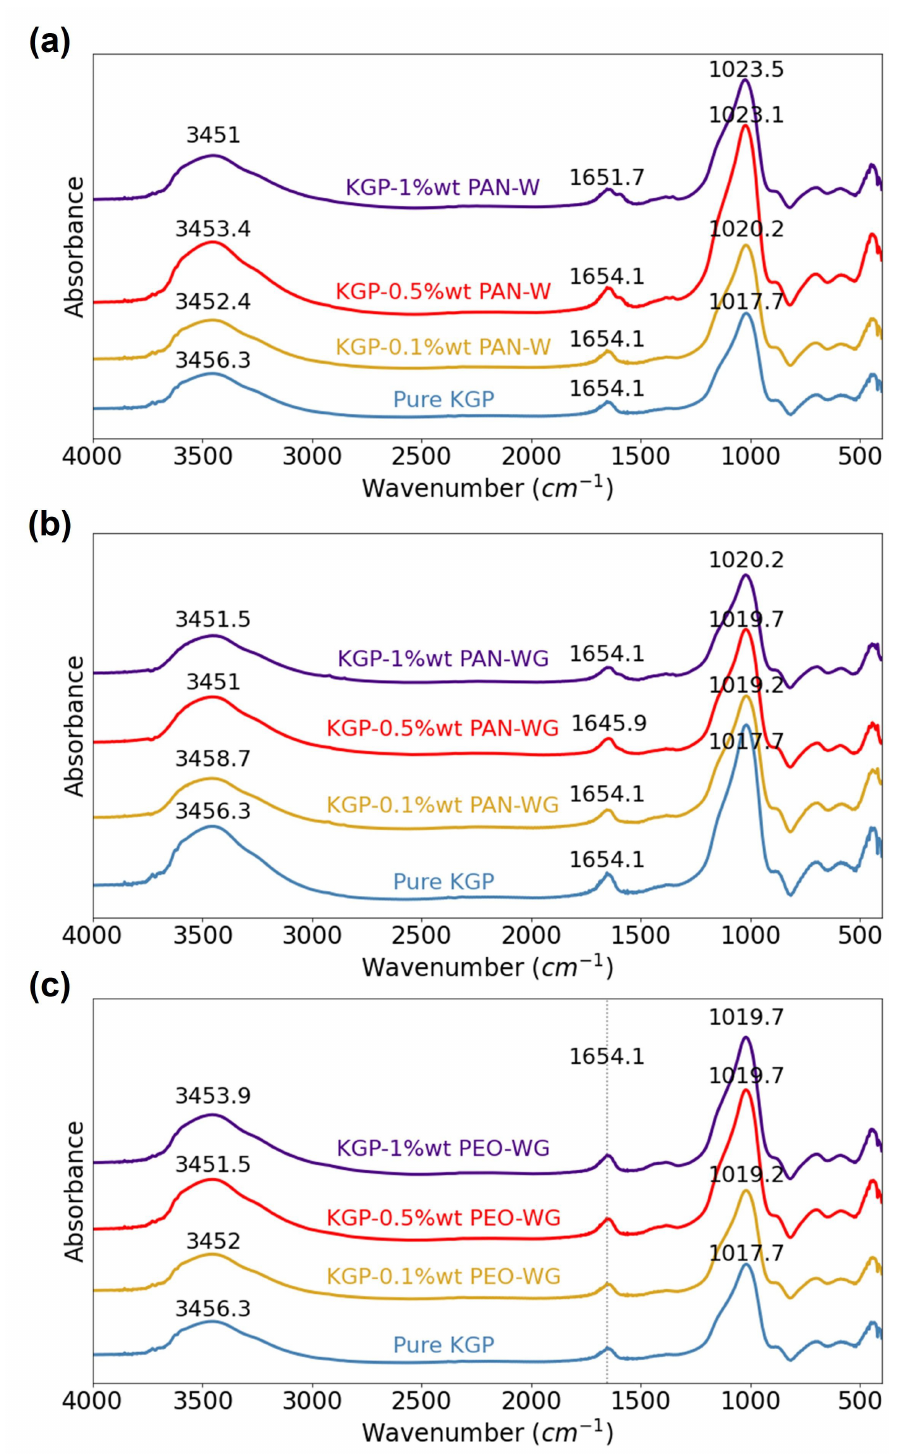
Figure 6. FTIR spectra of KGP and electrospun-fiber-reinforced KGP composites: ( a ) KGP and KGP/PAN-W. ( b ) KGP and KGP/PAN-WG. ( c ) KGP and